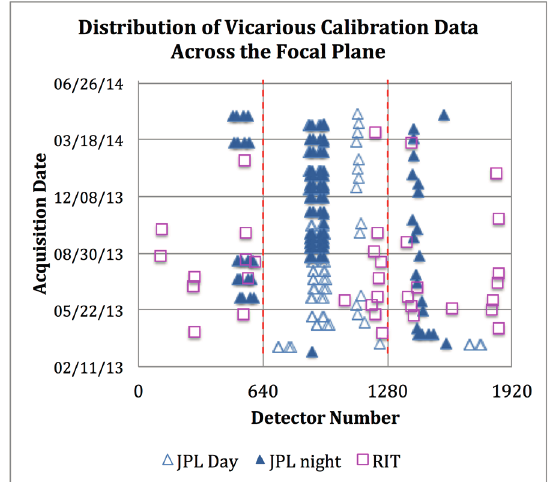
Figure 5. Distribution of vicarious calibration data across the TIRS focal plane. Dashed red lines indicate the boundaries between SCAs; SCA1 consists of detectors 1–640,